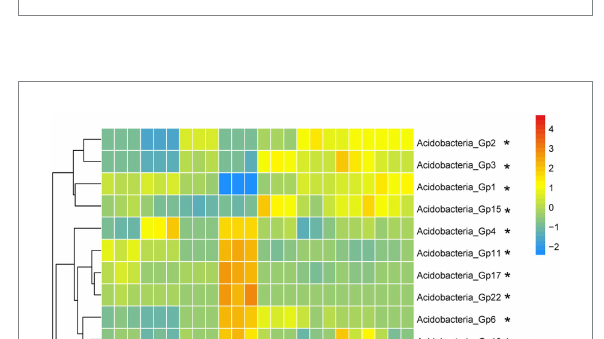
FIGURE 1 PCoA analysis of eight degradation vegetation types in Sanjiang plain. Vegetation types: original natural wetland (NW), shrub- invaded wetland (IW), w shrub-dominated wetland (DW), etland